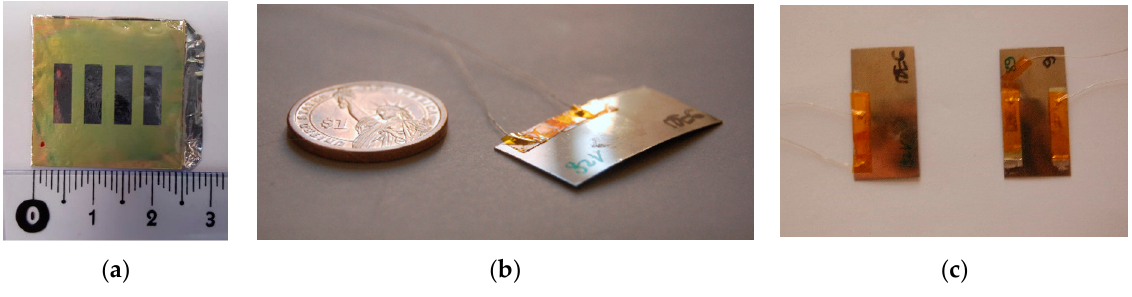
Figure 5. ( a ) Top view of the realized PZT thin films; ( b ) Piezoelectric bimetal with one PZT thin film; ( c ) Piezoelectric bimetals with one and two PZT thin films.